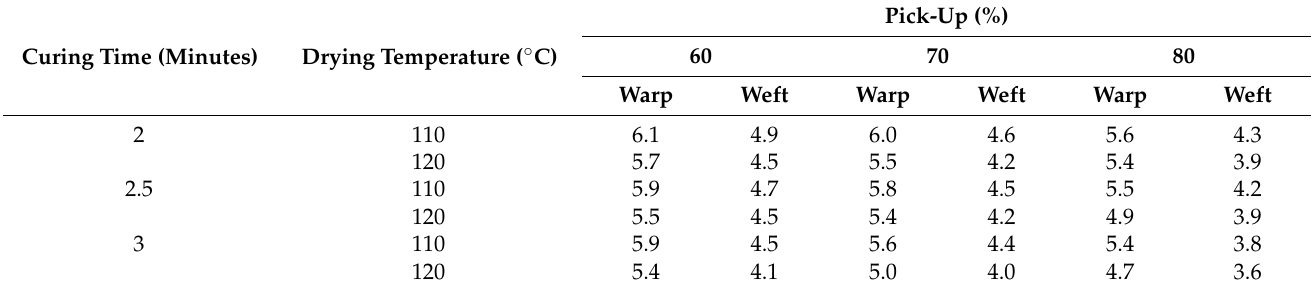
Table 6. Relationship between drying temperature, curing time, pick-up and tearing